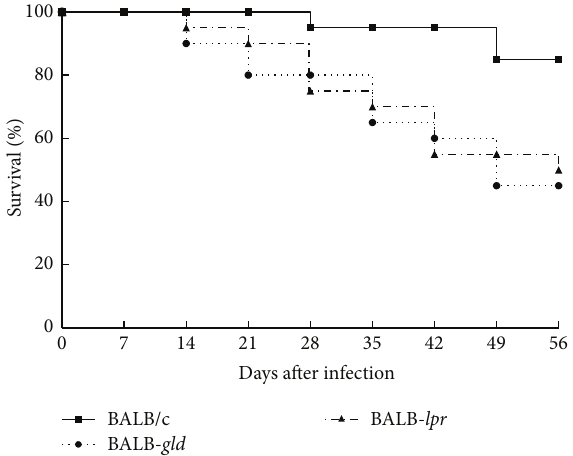
Figure 4: Mice expressing mutations in Fas and FasL display significantly greater mortality than wild-type BALB/c mice. A latent infection of BALB/c wild-type ( 𝑛 = 20 mice), BALB- lpr ( 𝑛 = 20 mice), and BALB- gld ( 𝑛 = 20 mice) mice was established as described and mice were observed for mortality for 10 weeks. Data displayed were compiled from two independent studies. Mortality for both BALB- lpr and BALB- gld was significantly greater than that for BALB/c wild-type mice ( 𝑃 < 0.002